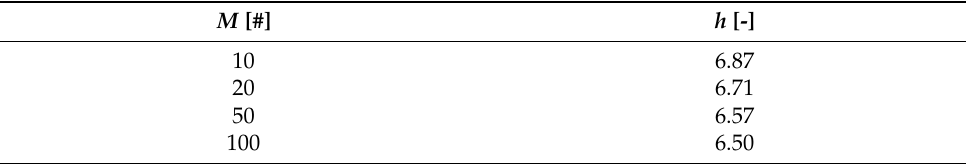
Table 6. Summary of h threshold